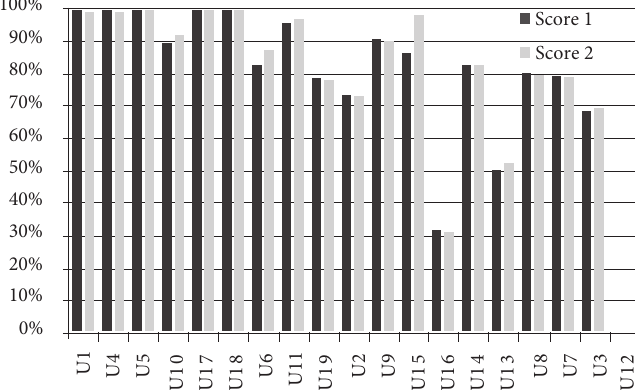
Fig. 3. University efficiency scores taking into account the environmental variables: Score 1 – without restrictions on the environmental variable weights, Score 2 – with restrictions on the environmental variable weights Source: Calculations by the